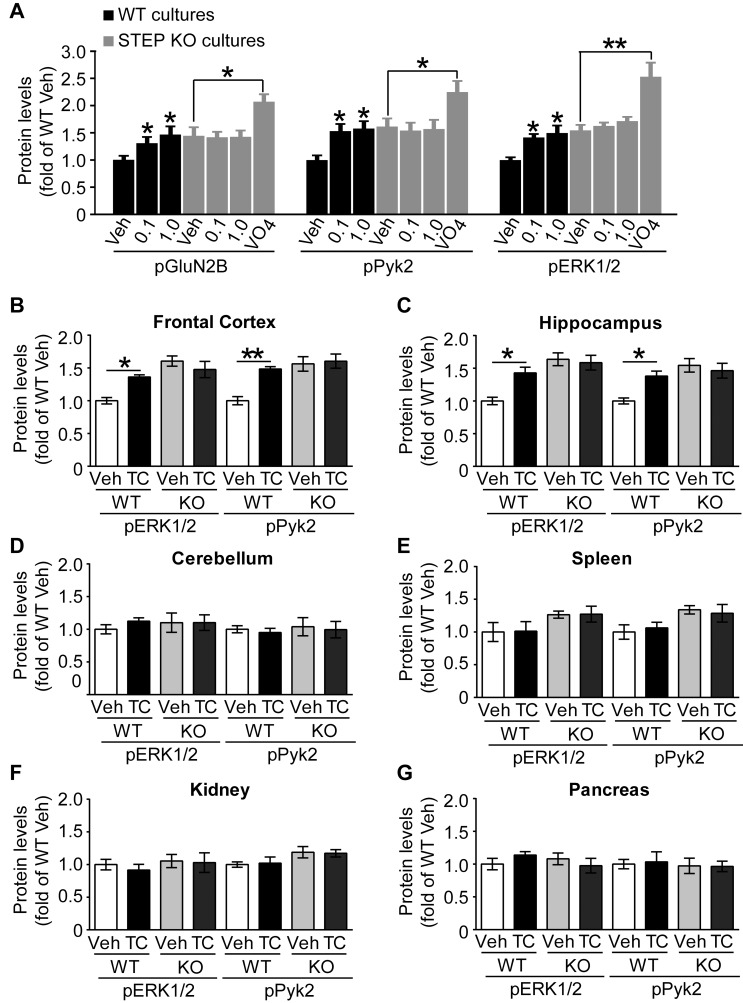
TC-2153 selectively inhibits STEP.(A) TC-2153 failed to increase tyrosine phosphorylation of STEP substrates in STEP KO cortical neurons. WT and STEP KO cultures were treated with TC-2153 (0.1 and 1 µM), vehicle (0.1% DMSO), or sodium orthovanadate (Na3VO4, 1 mM) for 1 h. Phosphorylation of GluN2B Y1472, Pyk2 Y402, and ERK1/2 Y204/187 was normalized to total protein level and then to GAPDH as loading control (*p<0.05, **p<0.01 one-way ANOVA with post hoc Bonferroni test, compared with veh-treated controls, n = 4). (B–G) TC-2153 increased the phosphorylation of ERK1/2 Y204/187 and Pyk2 Y402 in frontal cortex and hippocampus, but not in cerebellum, spleen, kidney, or pancreas, all tissues that do not have STEP. Mice were injected i.p. with TC-2153 (10 mg/kg; n = 4) or vehicle (n = 4) and were sacrificed 3 h later. Changes are expressed as the mean ± s.e.m. of pERK1/2 and pPyk2 normalized to total protein level and then to GAPDH (*p<0.05, **p<0.01; two-way ANOVA follow by Tukey's H.S.D. test).